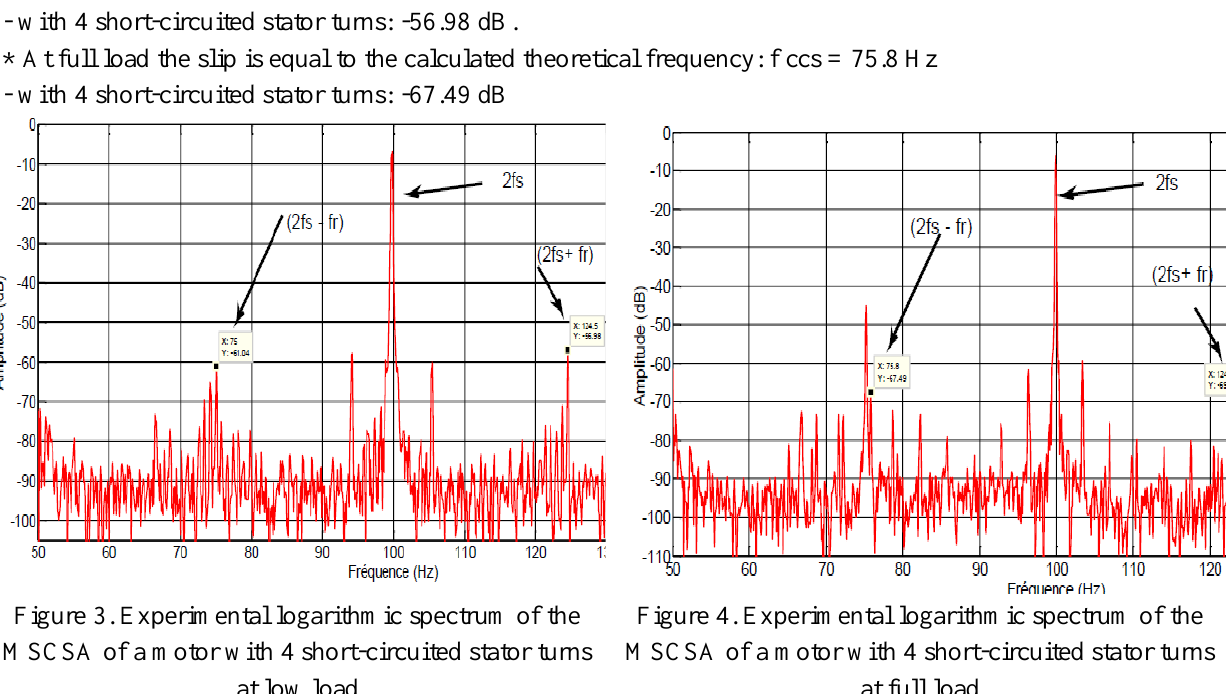
Figure 3. Experimental logarithmic spectrum of the Figure 4. Experimental logarithmic spectrum of the MSCSA of a motor with 4 short-circuited stator turns MSCSA of a motor with 4 short-circuited stator turns at low load at full